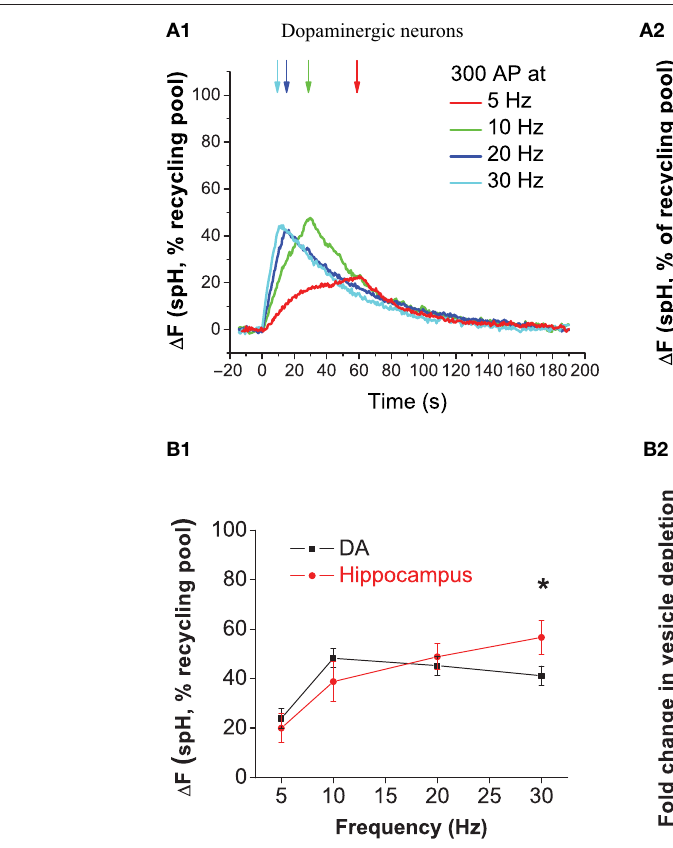
squares) have limited depletion of the recycling vesicle pool as compared to hippocampal neurons (red circles). * p < 0.05. (B2) With a six-fold increase in stimulus frequency from 5 to 30 Hz, DA neurons (black bars) show an ∼ 1.7-fold increase in vesicle depletion as compared to ∼ 2.8-fold in hippocampal neurons (red bars). Data from B1 were normalized to spH vesicle pool depletion at 5 Hz. ** p < 0.005. Data are the average from 10, 11, 16, and 14 DA neuron experiments and 10, 8, 13, and 8 hippocampal neuron experiments at 5, 10, 20, and 30 Hz, respectively. Error bars are